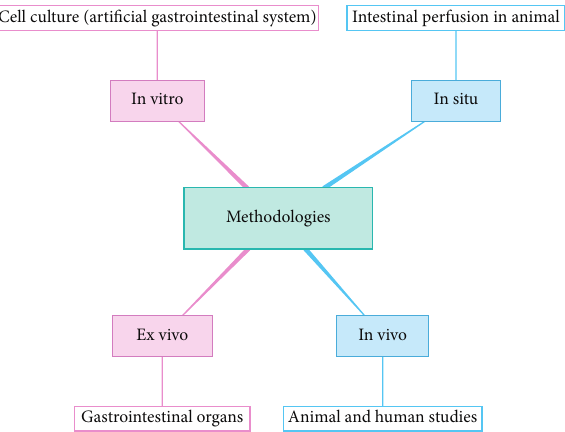
Figure 1: Bioavailability and bioaccessibility determination methods of bioactive